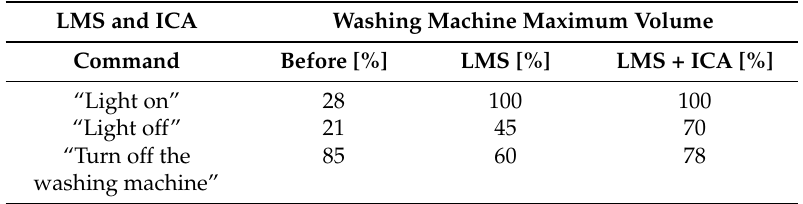
Table 6. The results of recognition success rate for washing machine